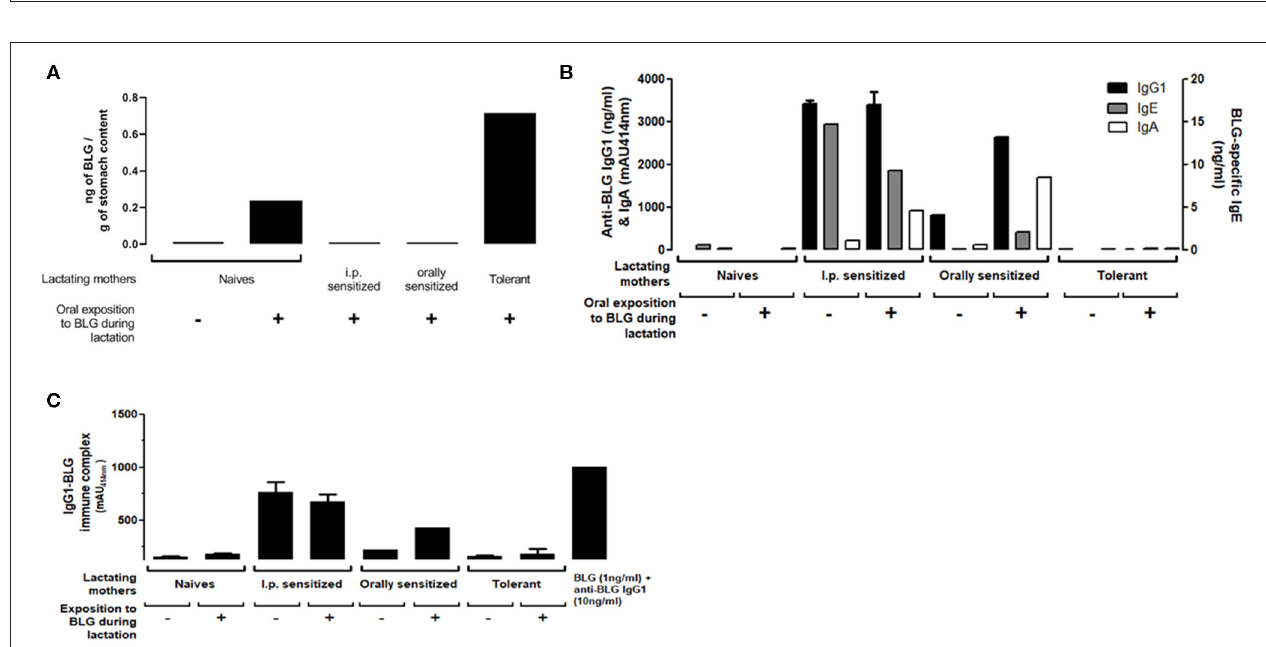
FIGURE 2 | (A) BLG antigen, (B) BLG-Specific IgG1 (black bars), IgA (white bars) and IgE (gray bars) and (C) IgG1-BLG immune complexes detected in milk collected 10 days post-partum from naïve, sensitized or tolerant mothers exposed ( + ) or not (–) to 1mg of BLG every other day during lactation. Assays were performed on stomach contents collected from pups 4h after the exposition of their fostered mothers. For BLG-specific IgA and IgG1-BLG immune complexes, absorbance signals (mAU 414nm ) obtained at the 1/25 dilution are reported. A positive control of IgG1-BLG immune complex was provided by mixing purified anti-BLG IgG1 monoclonal antibodies with purified BLG (right bar).